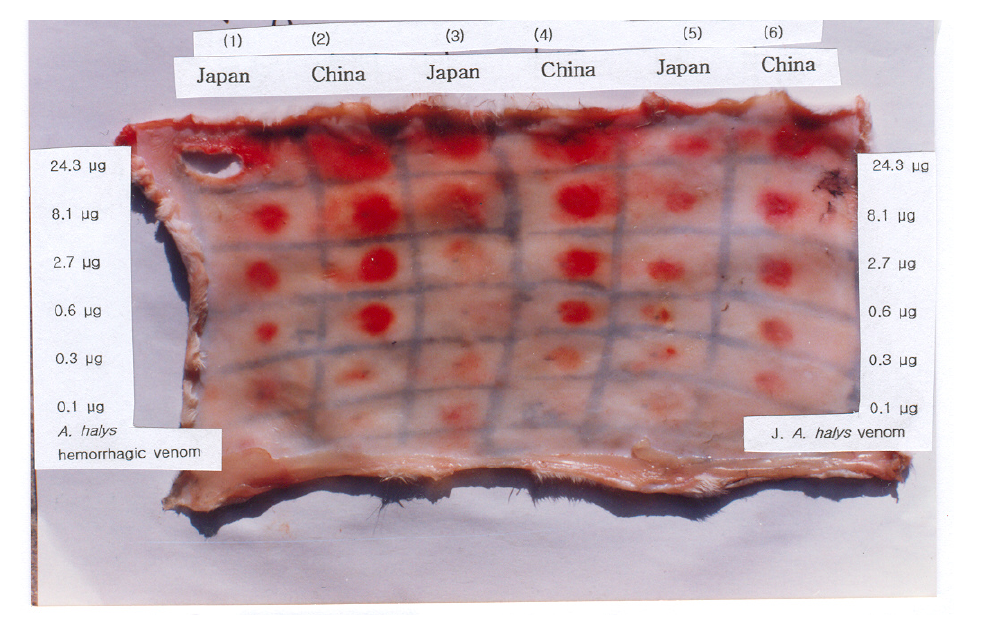
Figure 1: Minimum hemorrhagic doses and appearance of rabbit skin intracutaneously injected with either Agkistrodon halys [ A. halys ] venom from Japan (1, 3, 5) or Jiangzhe Agkistrodon halys [J. A. halys ] venom from China (2, 4, 6). A, B, C: Experiments carried out by three different experimenters.